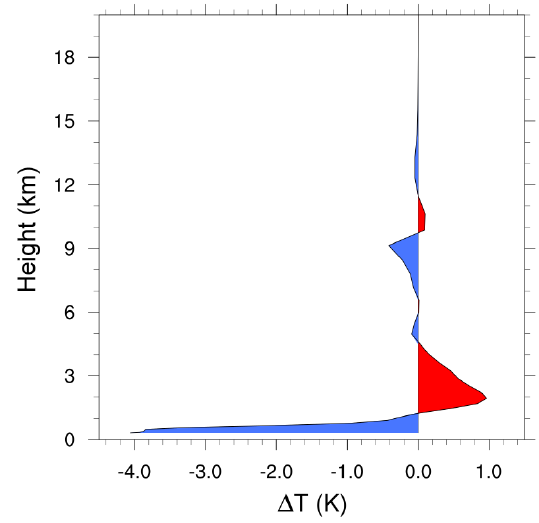
Figure 14. Mean vertical temperature change between the simula- tions VARHEIGHT and NOFIRE for a small domain around Fort Smith for 18:00UTC, 15 July